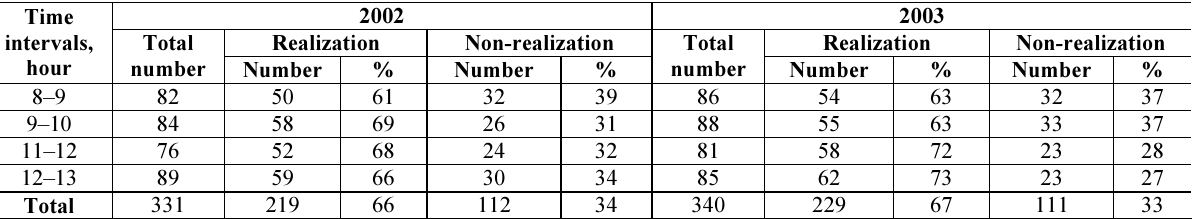
Table 5. Efficiency of prognostic connection of HCRF decrease (criterion –15 imp/h) and atmospheric pressure (without criterion) between two adjacent days at an interval 1.2–1.6 MeV at various time intervals in Vilnius in 2002–2003